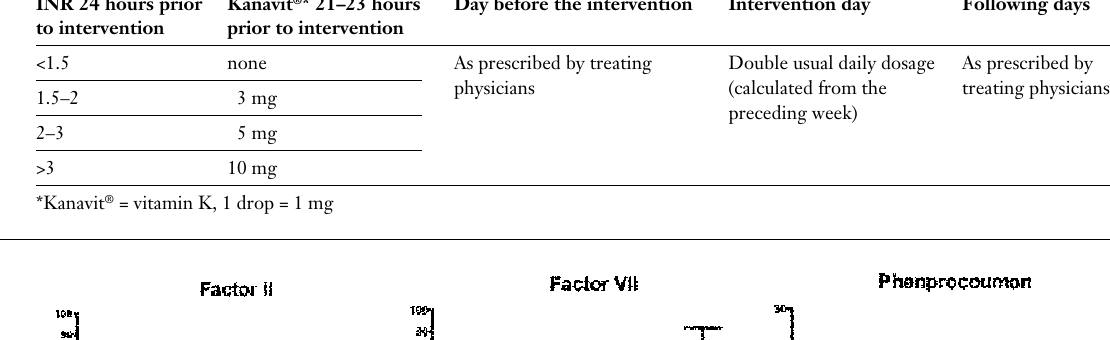
The courses of the serum levels of the coagulation factors II and VII and phenpro- coumon are shown for the analyses 21–23 hours prior to the intervention “day prior”, immediately before the heart catheterisation (“catheter”) and the values obtained 22–26 hours after the catheter (“day